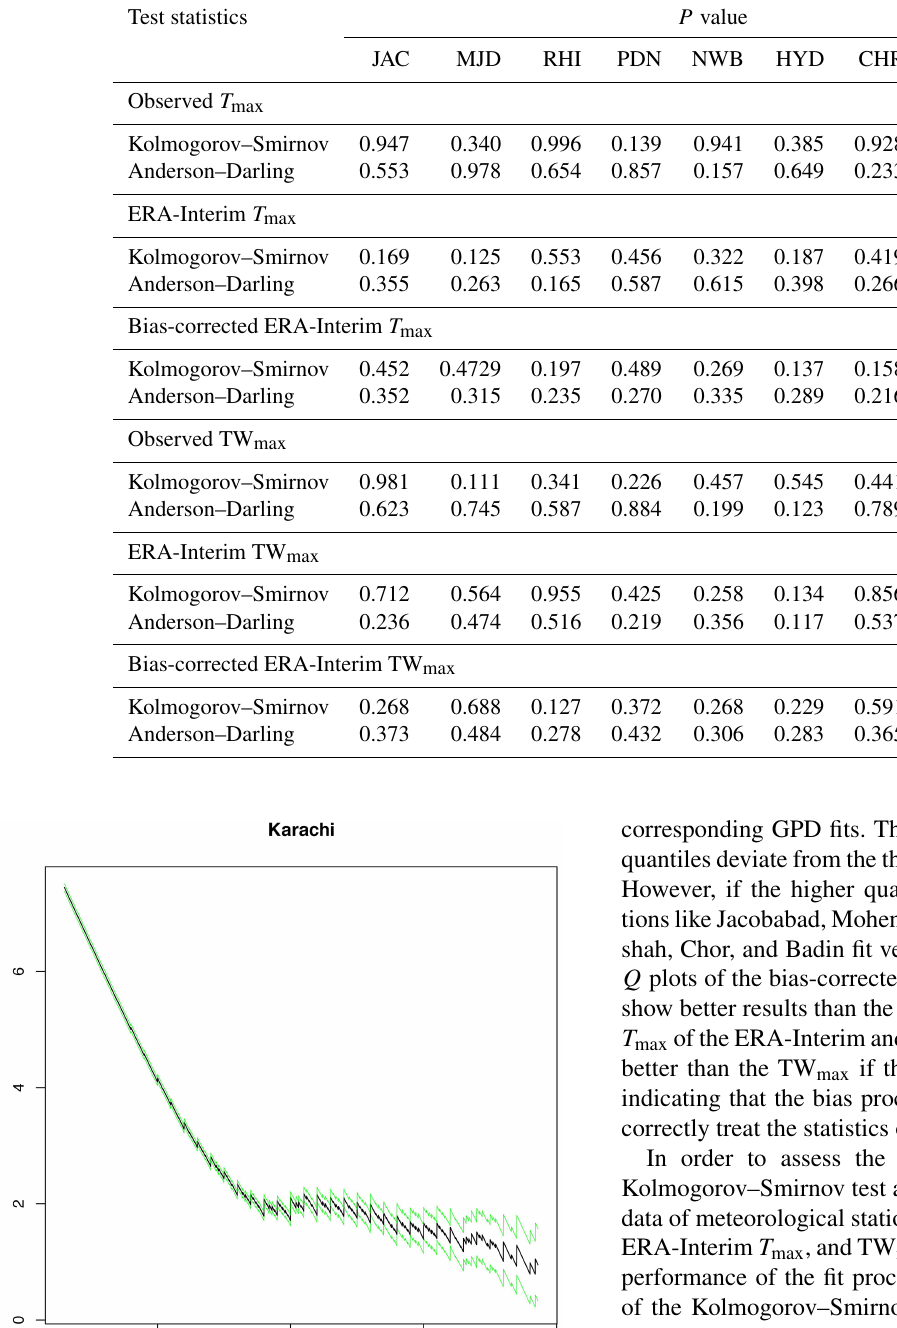
Table 2. Results of the Kolmogorov–Smirnov goodness of fit test and Anderson–Darling test between empirical and GPD fits.